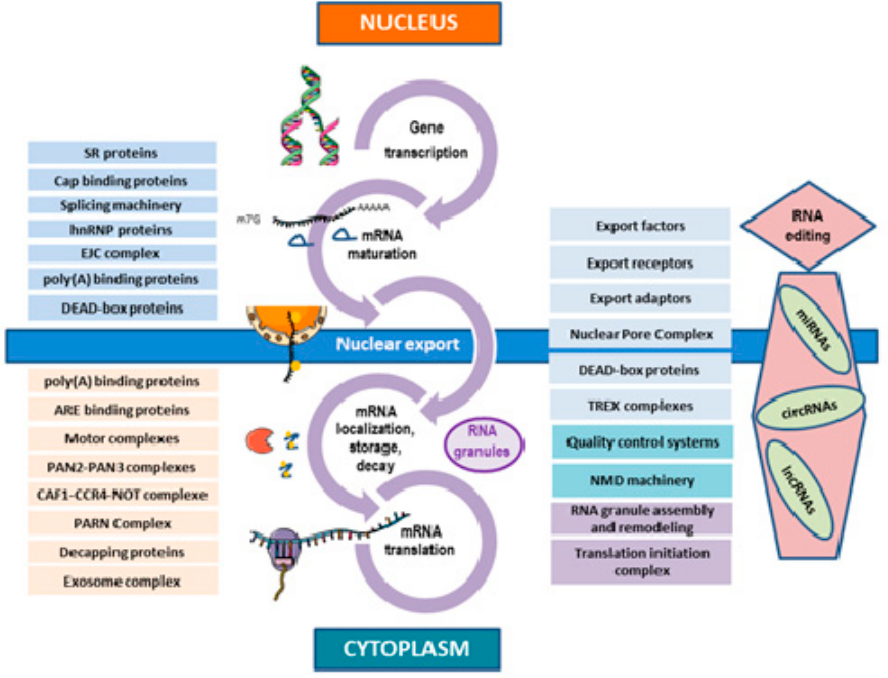
Figure 2. The mRNA life-cycle. This figure sums-up the different steps of the mRNA life-cycle from gene transcription to mRNA translation and degradation, occurring both in the nucleus and cytoplasm. At each step, the role of important groups of complexes, RBPs, proteins, and regulatory RNAs is shown. This figure highlights the continuity of RBP functions all along the process, even during the nuclear export. Many RBPs embedded onto mRNAs during transcription are able to cross subcellular boundaries and play a role in further steps. In blue are depicted RBPs with actions in the nucleus and factors involved in RNA nuclear export, in dark blue are systems associated with mRNA quality control, in pink are elements influencing mRNA stability and localization, and in dark purple are elements associated with mRNA fate in cytoplasm (granules and translation control).